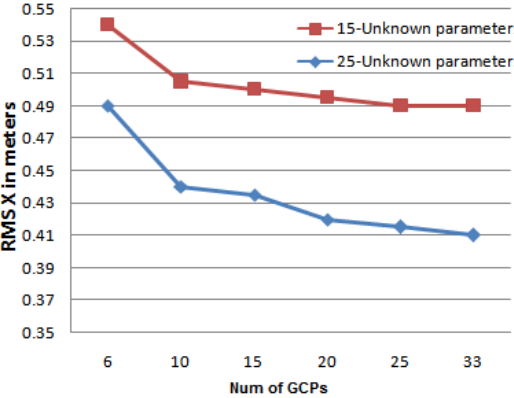
Figure 4. RMS in X-coordinate of ICPs as function of GCP number